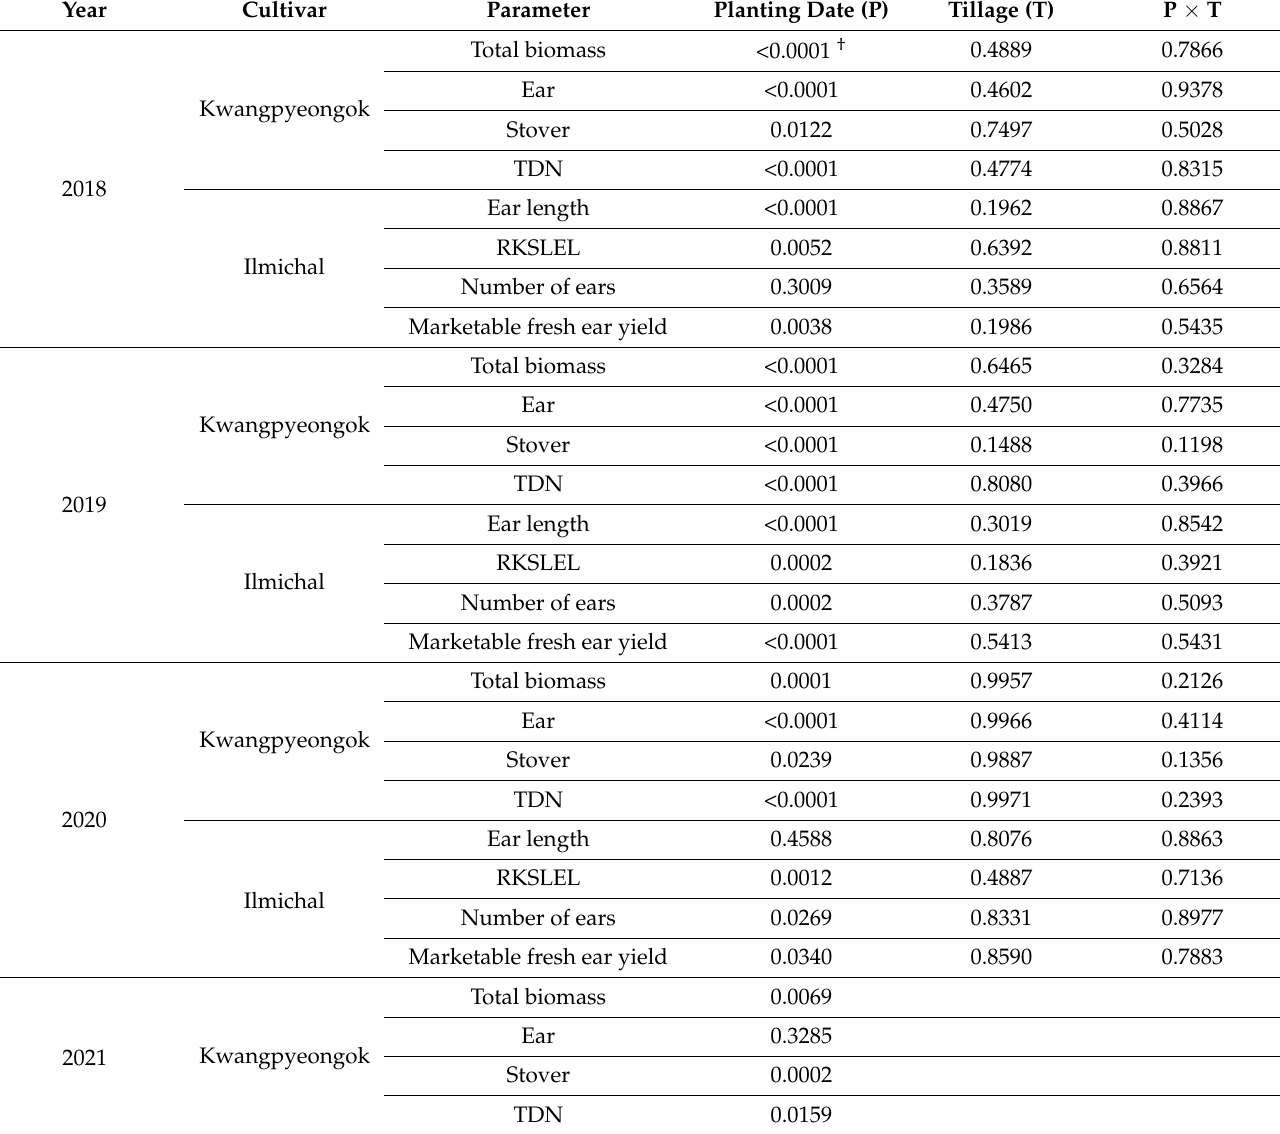
Table 9. Statistical analysis of the yield and yield components of two maize cultivars (Kwangpyeon- gok and